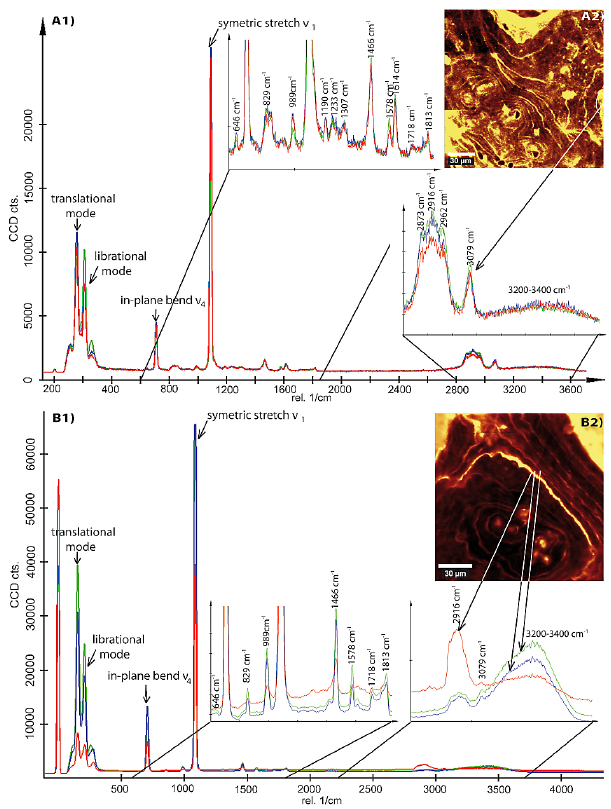
Fig. 7. Raman spectra obtained on a skeleton sample of P. lutea showing the characteristic peaks for aragonite (translational mode at 155cm − 1 , librational mode at 208cm − 1 , in-plane band at 710cm − 1 and symmetric stretch at 1085cm − 1 ) . Regions of mi- nor peaks are zoomed out: 600–1850cm − 1 and 2800–3600cm − 1 . Raman spectra using longer integration times were obtained after mapping the region marked in the fluorescence map in (A2) and (B2) with following settings for (A1) : 532nm laser wavelength, centered at 2000cm − 1 , integration time of 0.5s and 10 accumu- lations, 100 × Nikon objective, analyzer set 90°to laser wavelength and (B1) : 488nm laser wavelength, centered at 2400cm − 1 , inte- gration time of 6s and 10 accumulations, 100 × Nikon objective. (Raman spectra were derived in different points and displayed by different